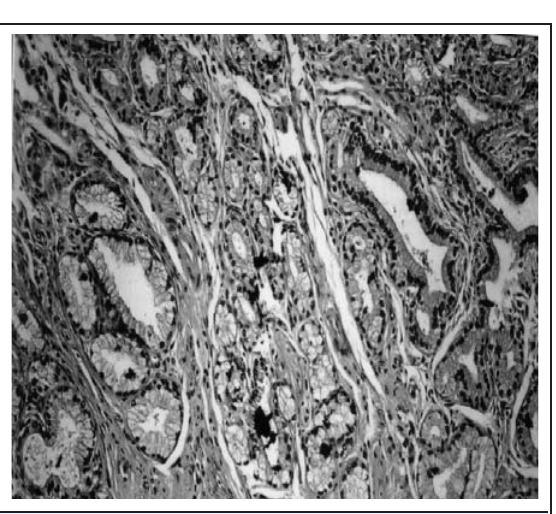
Figure 1. Gastric metaplasia in chronic cholecystitis (H&E X100).